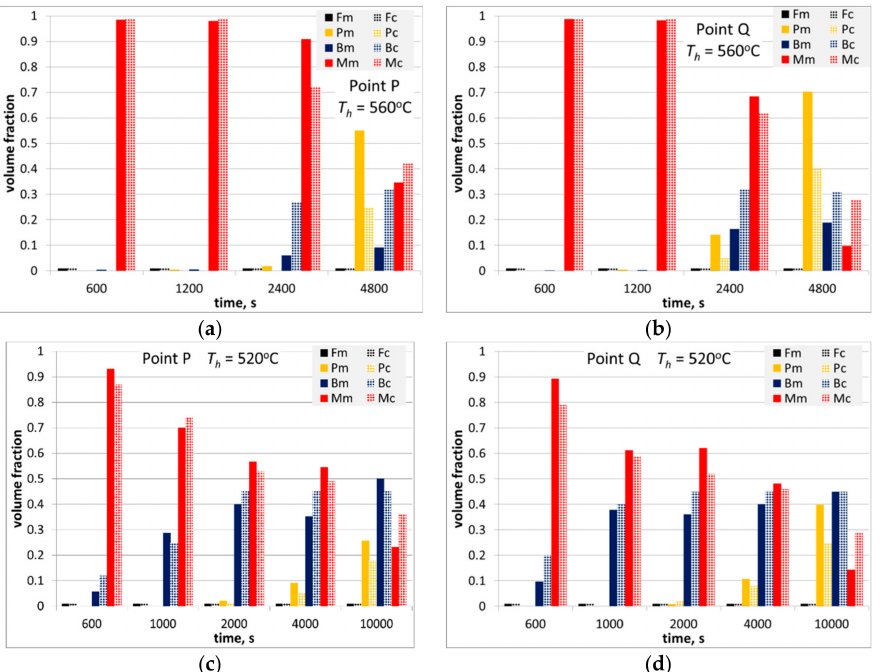
Figure 16. Measured and calculated volume fraction of phases in steel A after physical simulations described in Section 3.3, holding temperature 560 ◦ C ( a , b ) and 520 ◦ C ( c , d ) in the massive part of the forging ( a , c ) and in the thinner part ( b , d ).